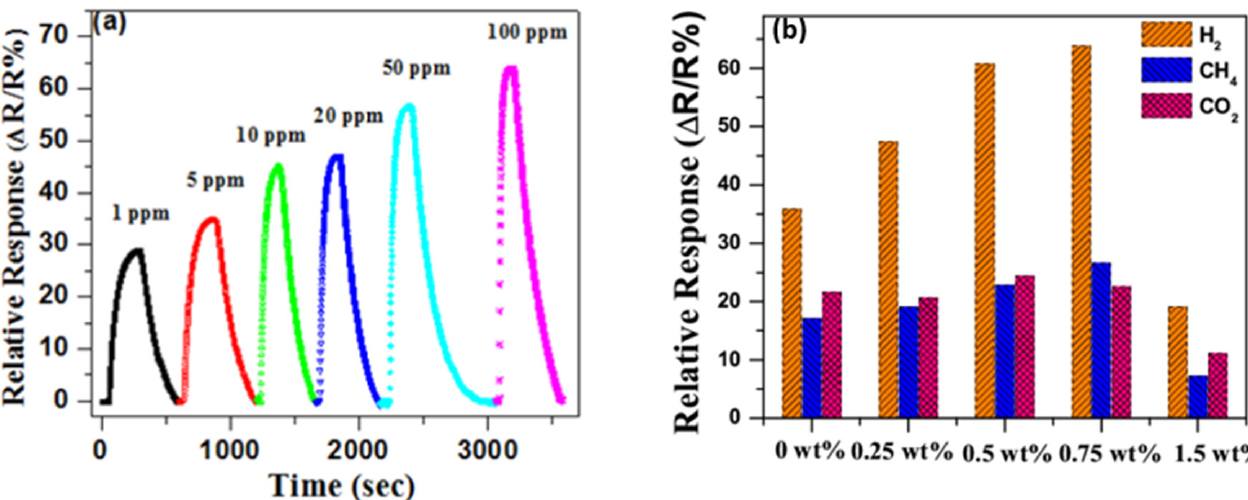
Figure 45. ( a ) Relative response of a 0.75 wt% rGO loaded sensor at an operating temperature of 150 °C with increasing gas concentration from 1 ppm to 100 ppm. ( b ) Selectivity histograms for pristine and rGO-loaded sensors with Ni-doped ZnO nanostructures [198]. Copyright (2018), with permission from American Chemical Society.